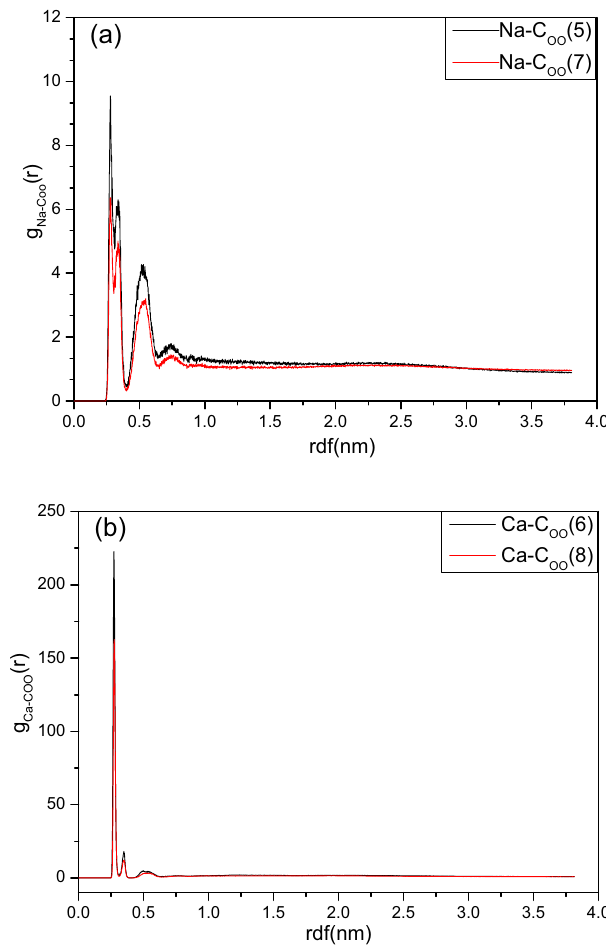
Figure 4. Radial distribution function (RDF) g Na-COO (r) of ( a ) Na + -C OO in systems (5, 7); ( b ) Ca 2+ -C OO in systems (6,